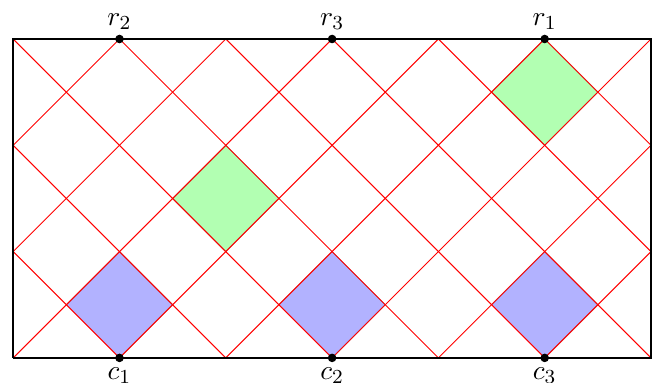
Figure 8. Summary of the boundary causal structure, as revealed by the lemmas in this section. Each input region (blue) is the domain of dependence of a single interval (Lemma 7). The negatively oriented future boundary of V and positively oriented future boundary of V 1 and similarly for V , V and V (Lemma 8). The joint future of c 2 3 3 , V 1